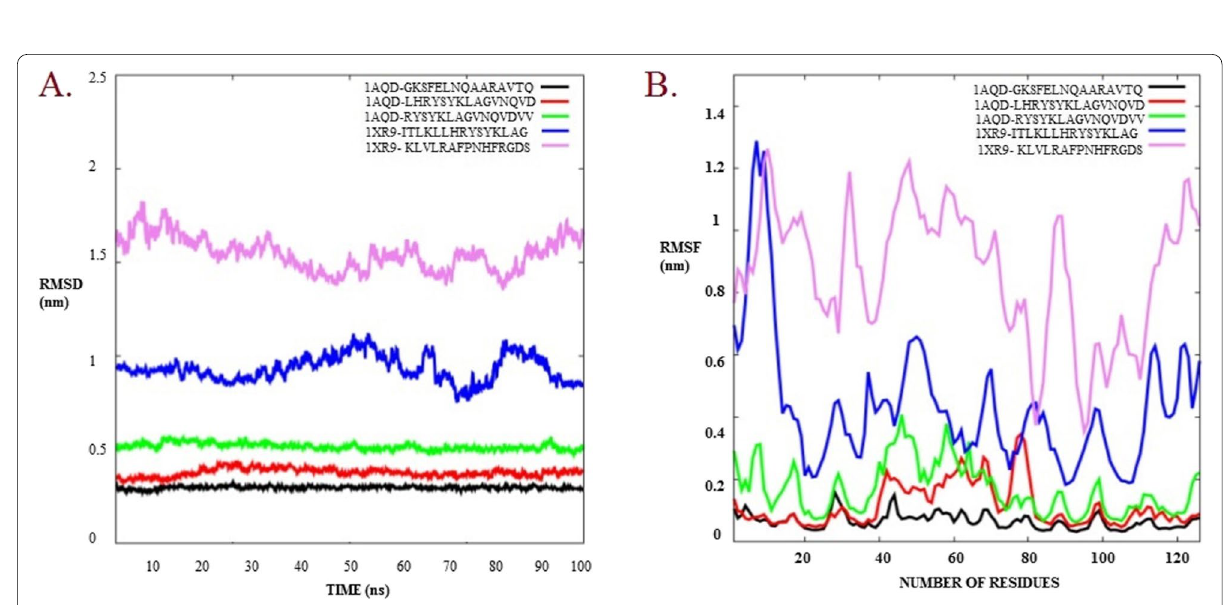
Fig. 6 RMSD ( A ) and RMSF ( B ) plots for all the five docked